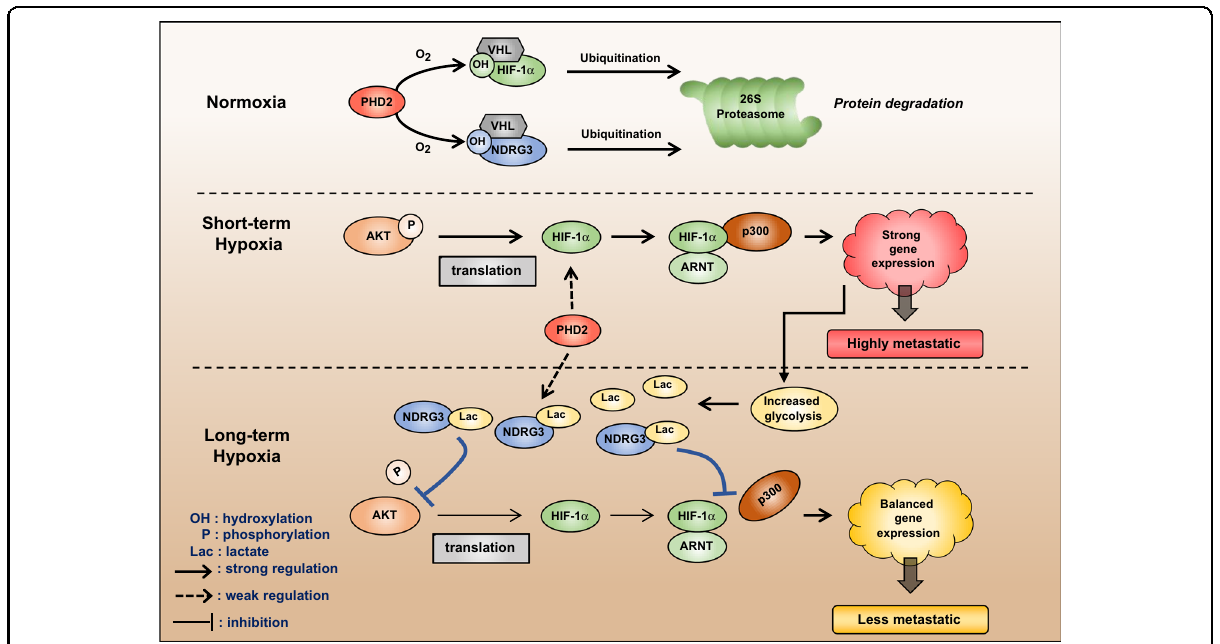
Fig. 8 Proposed hypothesis for the mechanism whereby NDRG3 counterbalances the HIF signaling pathway as a feedback regulator. OH hydroxylation, P phosphorylation, Lac